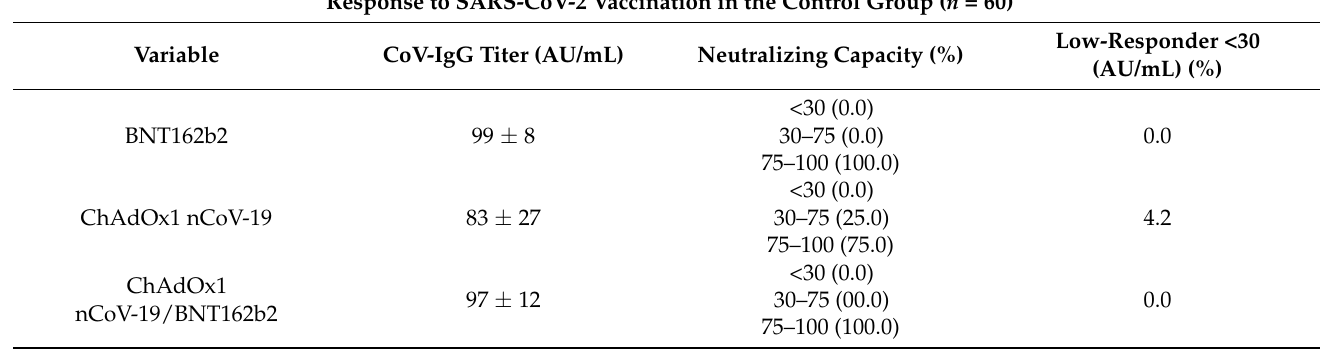
Table 5. Comparison between different vaccination schemes in participants of the control group (Scheme 0) and anti- body titers (ANOVA p = 0.021) after vector-based vaccination and comparable results after mRNA-based and/or